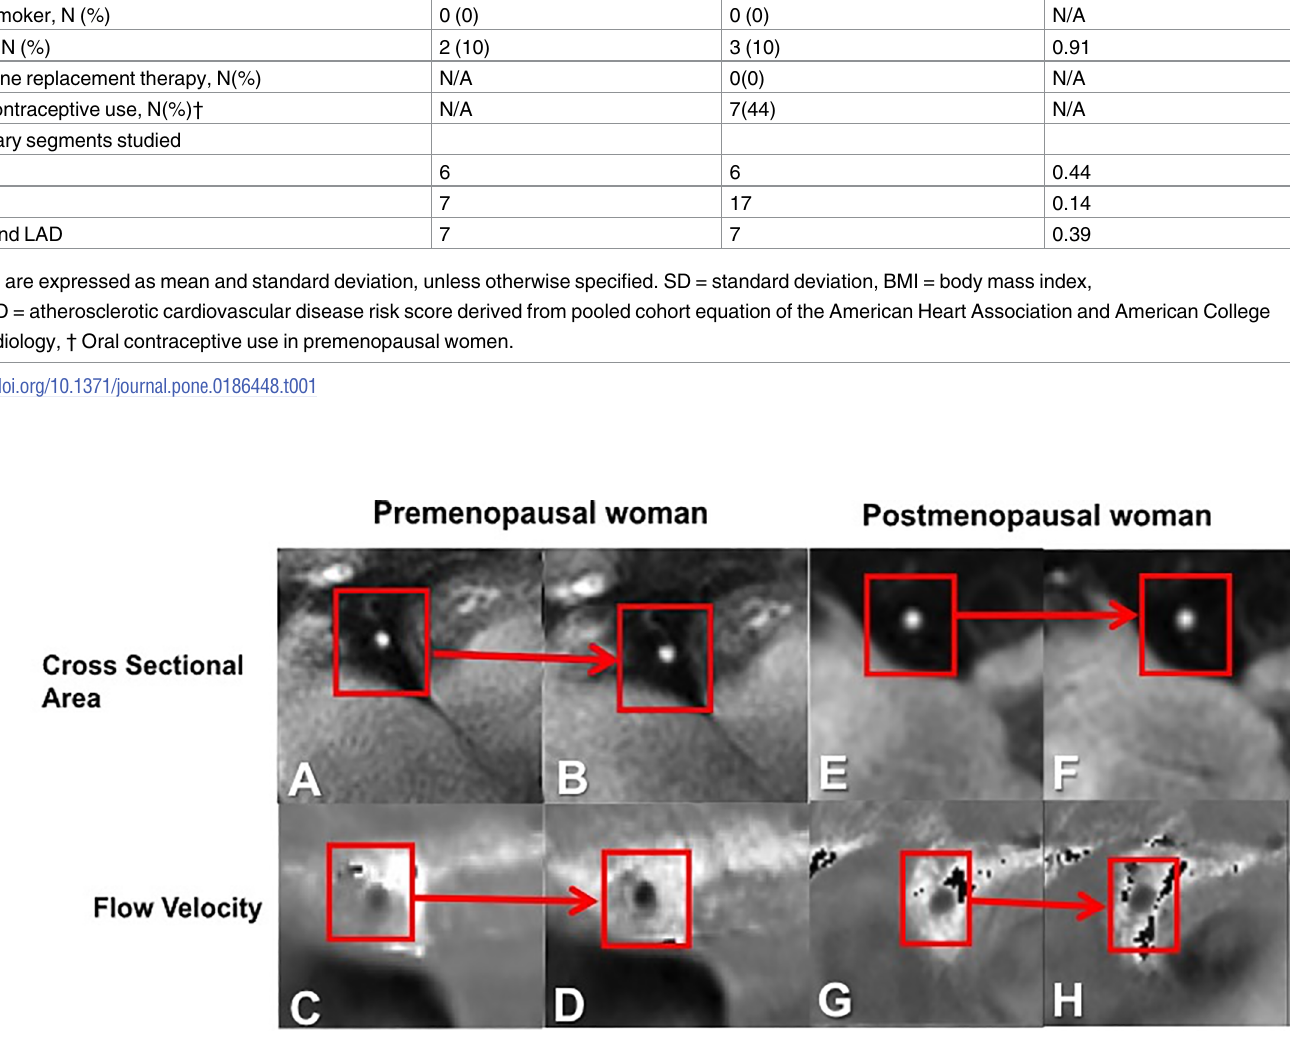
Fig 1. Representative coronary arteryimages for cross sectional area and blood velocity. Examplein a healthy premenopausalwoman demonstrating a right coronaryartery (RCA) cross section ( A ) at rest ( B ) and duringisometric handgripexercise (IHE) showingvasodilation. Magnifiedflow velocity image of the RCA in the same subject is shown at rest ( C ) and during IHE ( D ) in diastole,whereinthe signal phase is proportional to flow velocity with the darker pixels during IHE indicating higher velocity in the caudal direction through the RCA. Examplein a healthypostmenopausal woman of the RCA cross section ( E ) at rest ( F ) and duringIHE showingno vasodilation. Flow velocity image of the RCA in the same postmenopausal subject is shown at rest ( G ) and duringIHE ( H ) in diastole, whereinthe signal darknessdoes not increaseduringIHE as it does in the